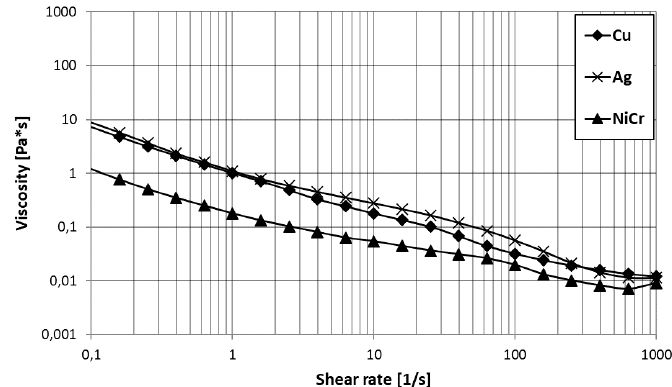
Figure 3. Flow curves of the Cu, Ag, and NiCr suspensions used in this study.